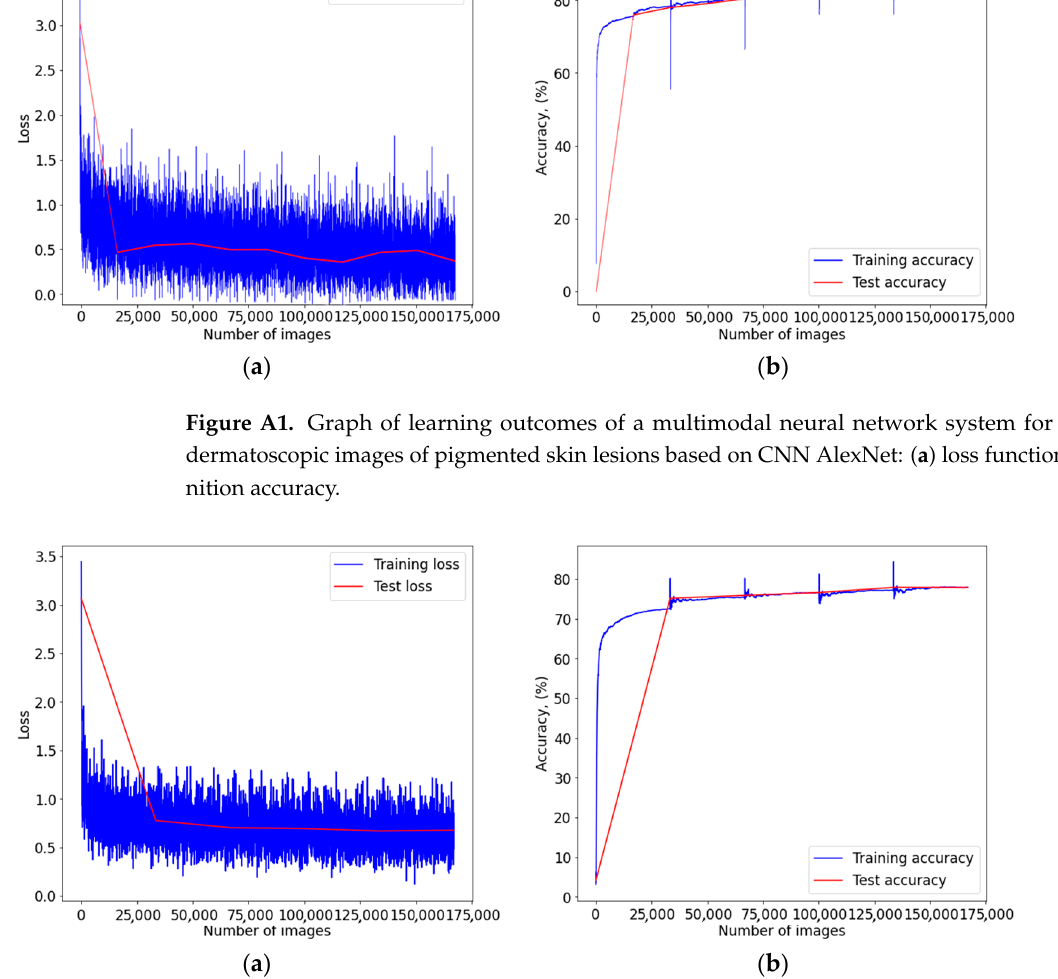
Figure A2. Graph of learning outcomes of a multimodal neural network system for classifying dermatoscopic images of pigmented skin lesions based on CNN SqueezeNet: ( a ) loss function; ( b ) recognition accuracy.